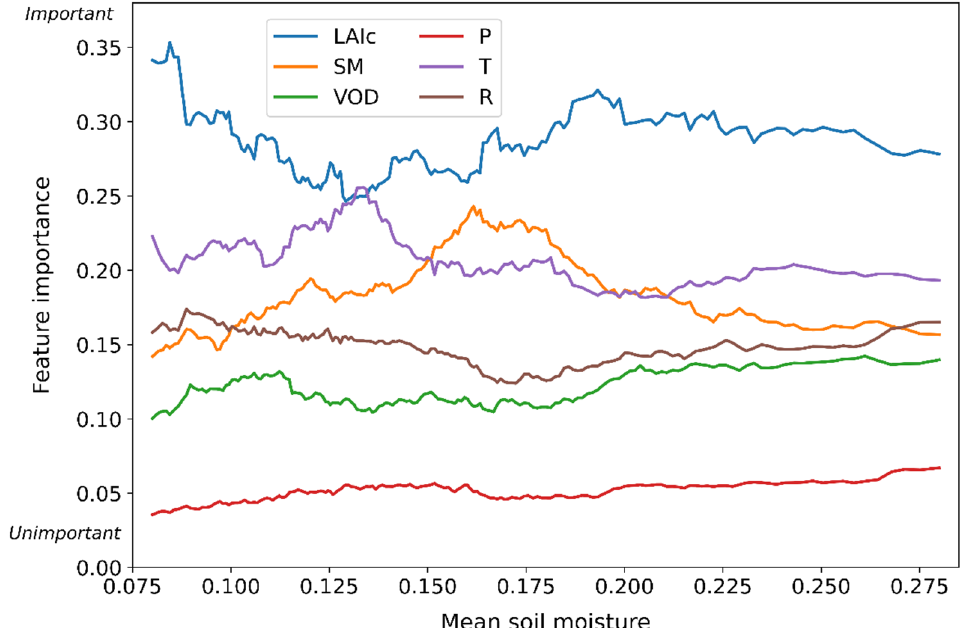
Figure 7. The level of feature importance of LAI climatology (LAI C ), soil moisture (SM), vegetation optical depth (VOD), precipitation (P), temperature (T) and radiation (R) from the “ full ” models against different soil moisture conditions.